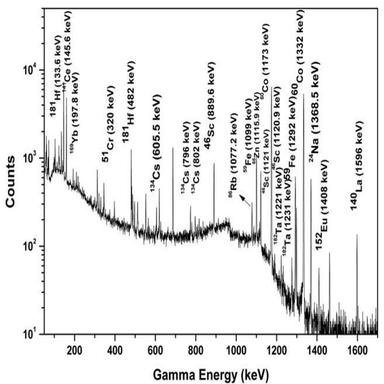
Typical gamma ray spectrum of windshield glass by INAA using Apsara-U research reactor (Irradiation time = 5 h; Flux ~ 1013 n/cm2 /s; Decay Time = 6 days).